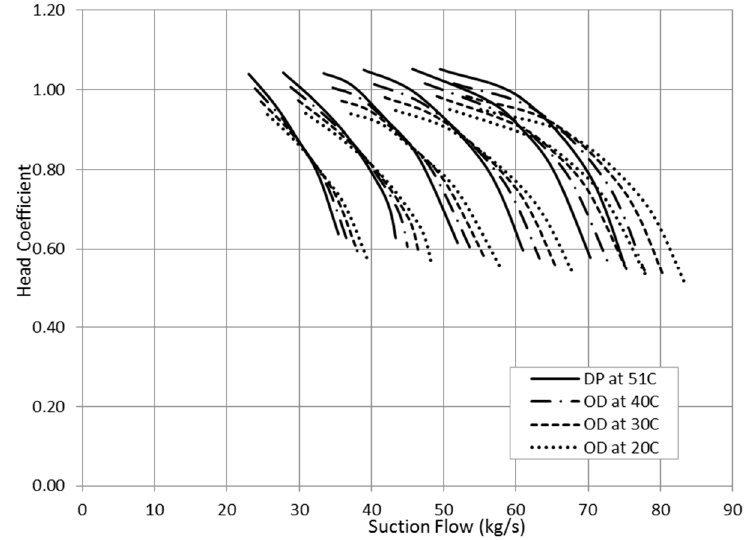
Figure 9. Effect of suction temperature on head coefficient.